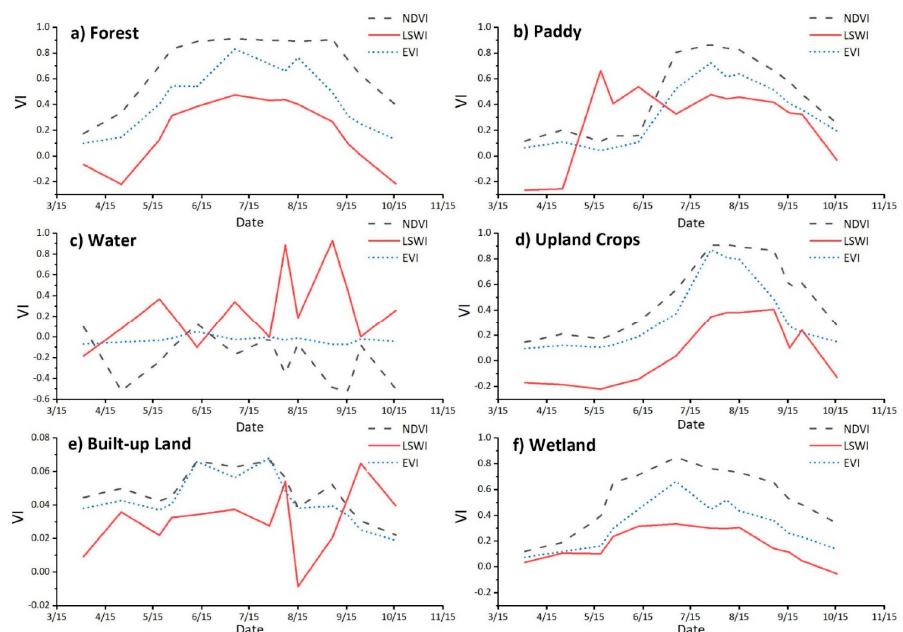
Figure 9. The seasonal dynamics of NDVI, EVI and LSWI for the major land cover types at select sites, extracted from the fused time series data. ( a ) Forest, ( b ) paddy, ( c )water, ( d )upland crops, ( e )built-up land, and ( f ) wetland. All sites were selected according to field photos and high spatial resolution Google Earth images.